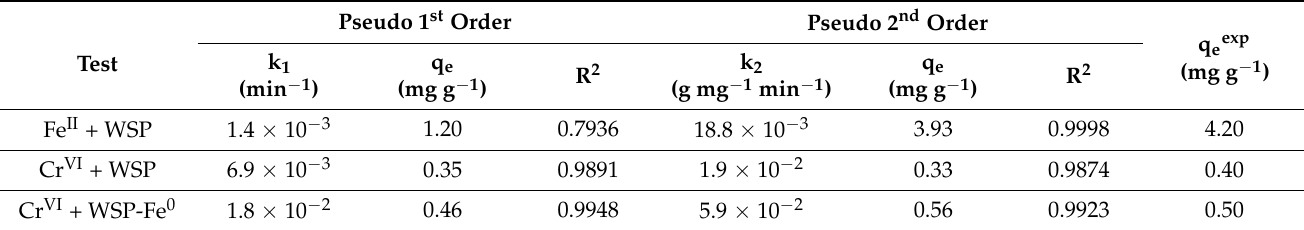
Table 1. Kinetic parameters of Fe II and Cr VI removal.